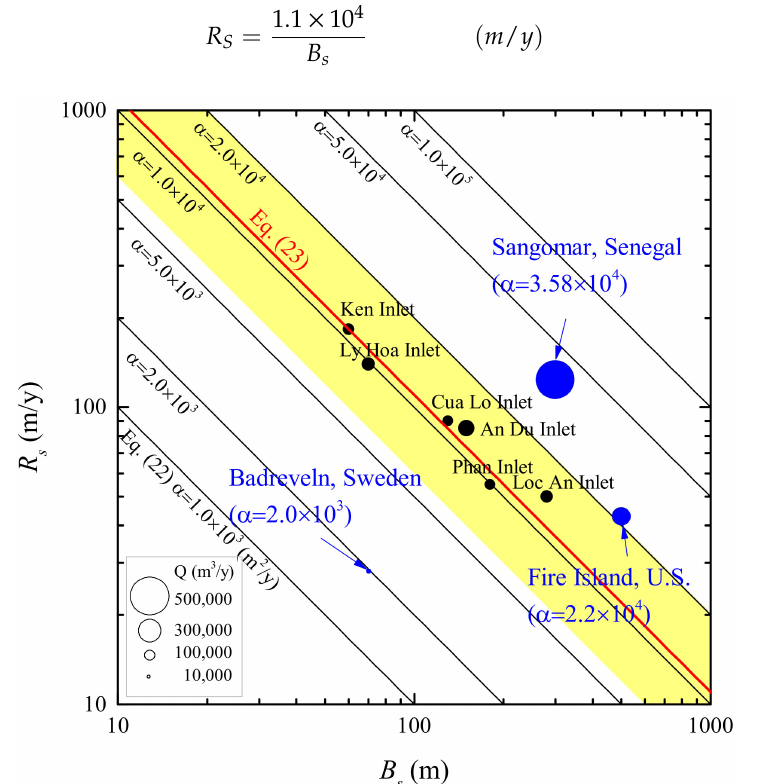
Figure 16. Relationship between sand spit growth rate and sand spit